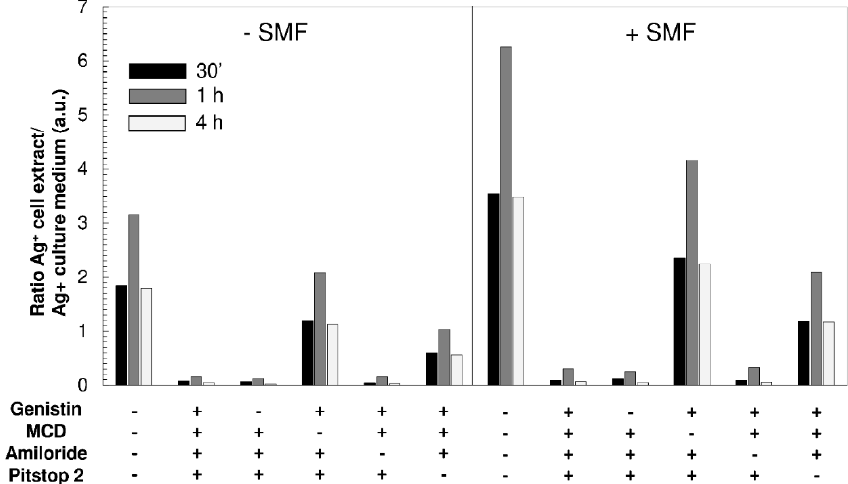
Figure 5. Inductively coupled plasmon optical emission spectroscopy (ICP-OES) analysis of the amount of silver nanoparticles synthesized using β - d -glucose (AgNPs-G) internalized by PBL cells previously exposed to SMF for 72 h and treated with endocytic pathway selective inhibitors (genistin, MCD, amiloride and Pitstop 2) as reported in Section 4.7 of Materials and Methods were further incubated with 2 × 10 3 AgNPs-G for 30 min, 1 h and 4 h. Data are reported as a ratio between the Ag + detected in cell extracts and those detected in the culture medium (absorbance in arbitrary unit, a.u.) from 3 independent experiments. Abbreviation: SMF = PBLs exposed or not exposed to 6-mT SMF. ( + ) presence and ( − )